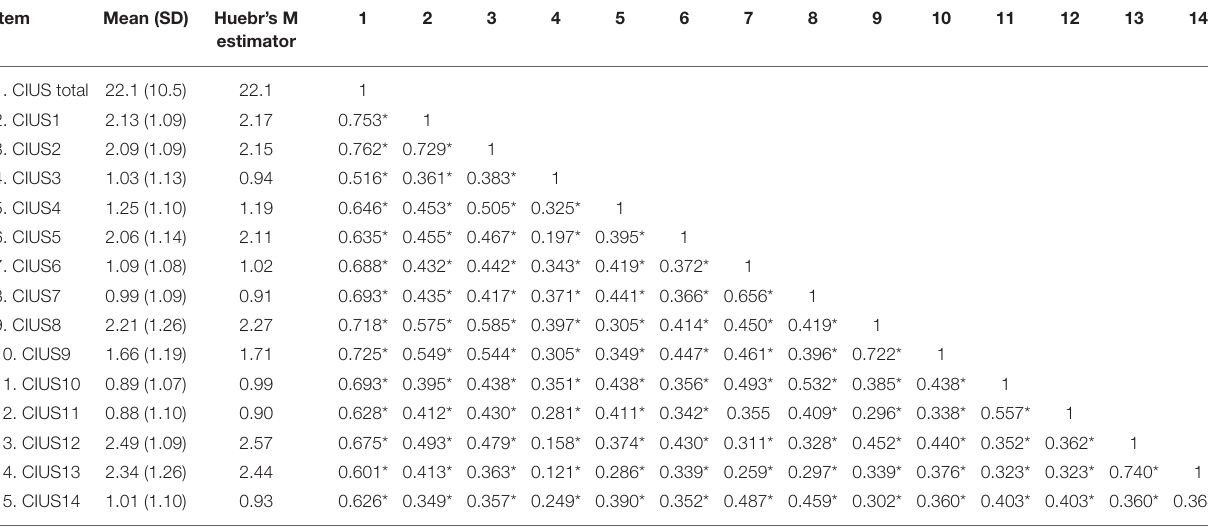
TABLE 2 | Means, robust estimator, and intercorrelations of the compulsive internet use scale items. Item